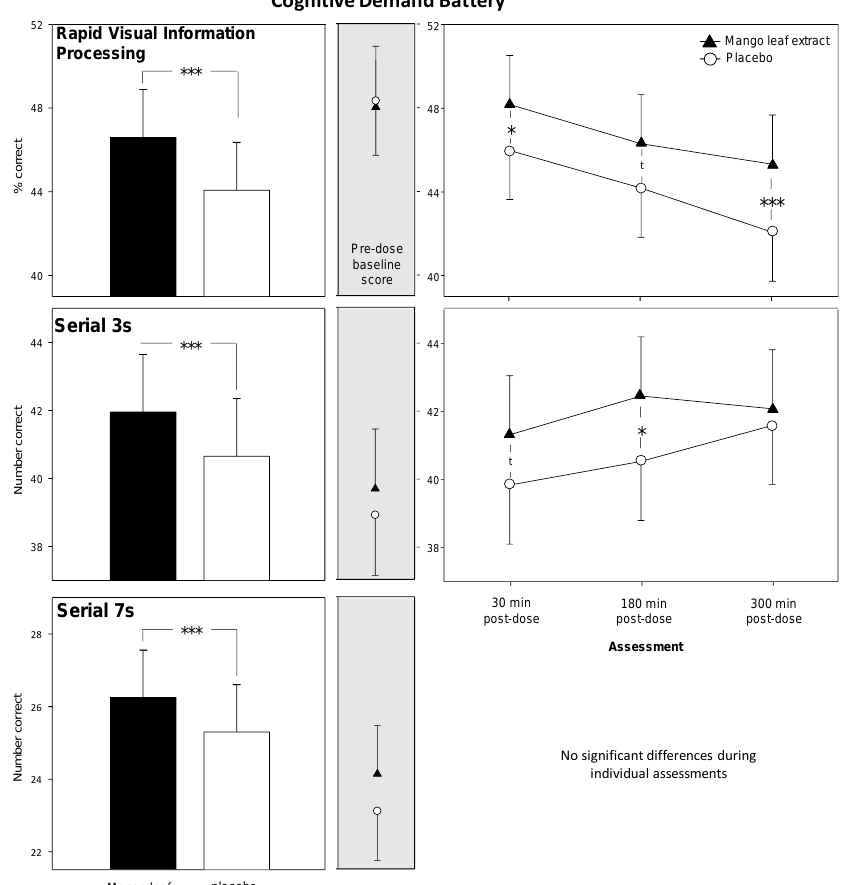
Figure 5. The effects of mango leaf extract on the Cognitive Demand Battery outcomes. Each task was repeated three times per assessment (total Cognitive Demand Battery (CDB) completion time, 30 min per assessment). Left-hand panels show the main effect of treatment averaged across assessments/repetitions; middle panels show the pre-dose baseline scores averaged across the three repetitions; right-hand panels show time course data from each post-dose assessment (averaged across the three repetitions per assessment) for those measures that saw significant effects on the planned comparisons (Bonferroni) of mango leaf extract versus placebo. t, p < 0.1; *, p < 0.05; ***; p < 0.001 in comparison to placebo. Number of participants contributing to the measure: RVIP, n = 64, Serial 3s / 7s, n =